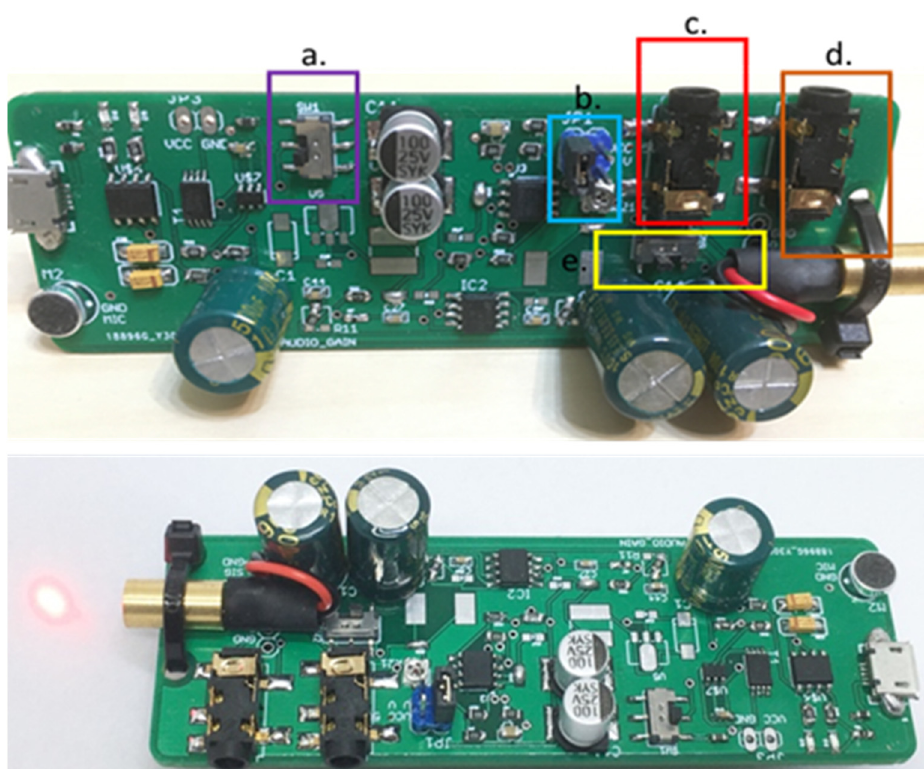
Figure 5. Laser audio transmission device. a displays the switch: up is open, down is closed. b shows the voltage switch, set to a voltage of 4.2 V, with the jump changed to 5 V (not recommended). c displays the audio input: one may use a 3.5-mm earphone plug to input the computer audio, and the laser will output the audio signal. d shows the audio output: one can confirm that the input audio is used normally and directly connects to a 3.5-mm earphone. e displays the switch between the microphone and audio input: it can be set to the left for audio input or to the right for microphone input.